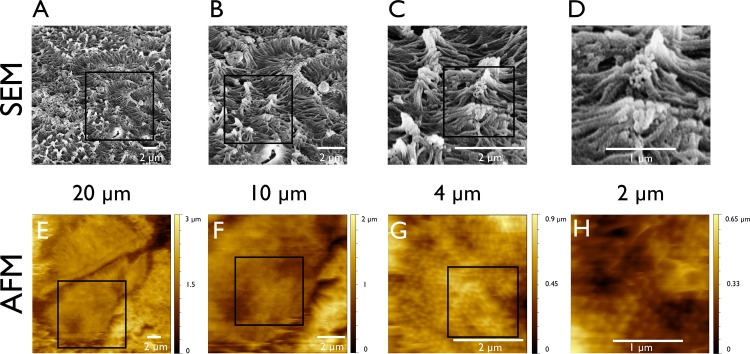
SEM and AFM of Caco-2 cells.(A-D) Scanning electron micrographs of Caco-2 cells at different magnifications. They are compared with atomic force micrographs of Caco-2 cells at the same magnification (E-H). The SEM micrographs display a cell surface completely covered with microvilli (A+B). At higher magnifications the clusters of microvilli appear linked at their tip (C+D). At high magnification the AFM visualizes highly ordered, equally distributed microvilli (G+H).